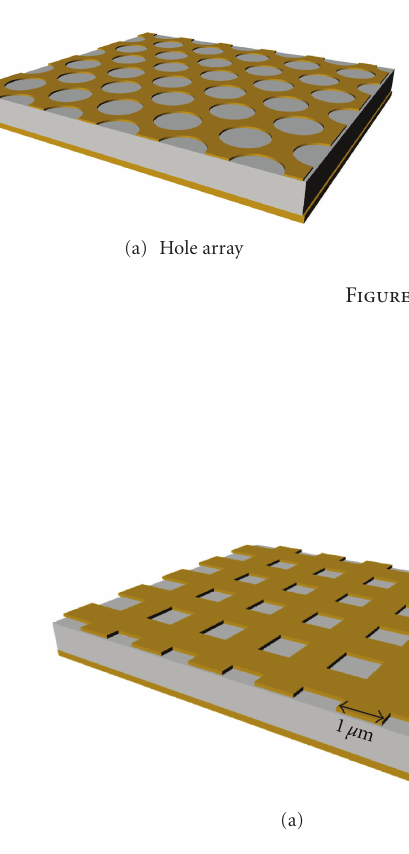
Figure 14: RCW simulations for inductive grid array shown in Figure 11(c). Here as the substrate, assumed to be ZnSe, is varied from 1.75 to 2.5 µ m. The resonant absorption wavelength shifts to longer wavelengths; however, the magnitude of the absorption remains near